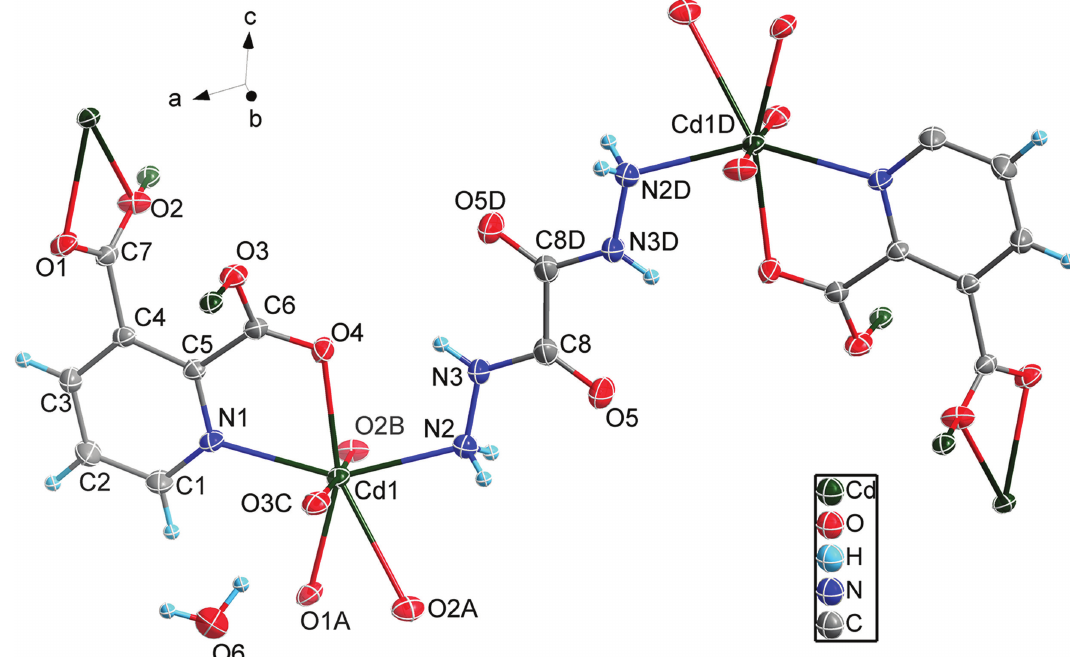
Table 1: Data collection and handling.